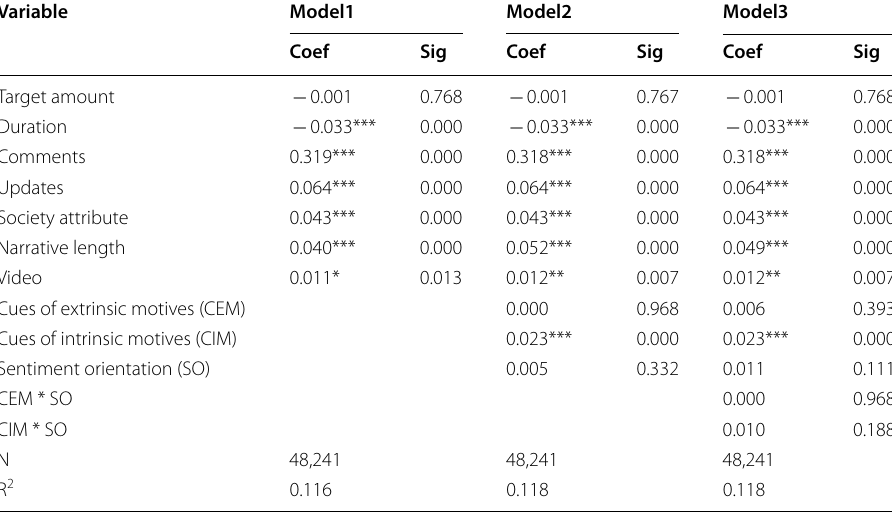
Table 7 Results of sentiment orientation model